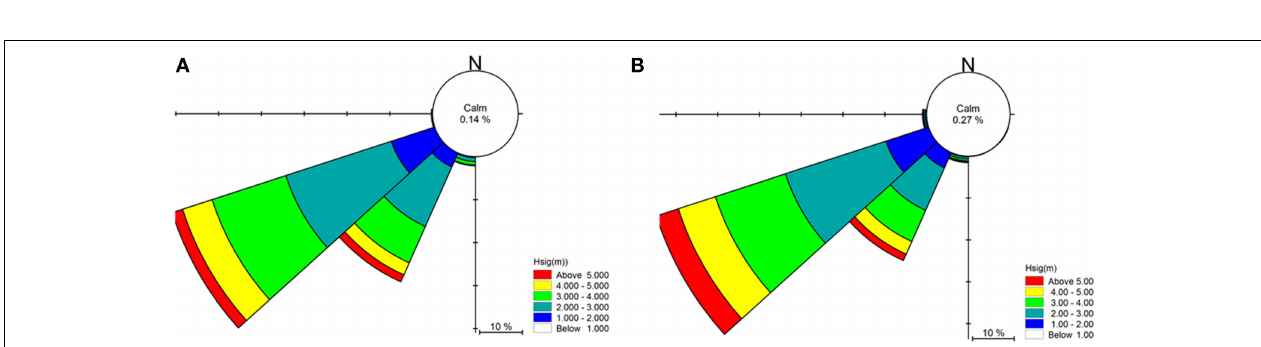
FIGURE 2 | Domain of the regional spectral wave model incorporating the eastern and western coastlines of Victoria, Tasmania and Bass Strait. The triangular irregular network used to inform the numerical wave model was created from the 0.0025 ◦ Australian national bathymetry grid.